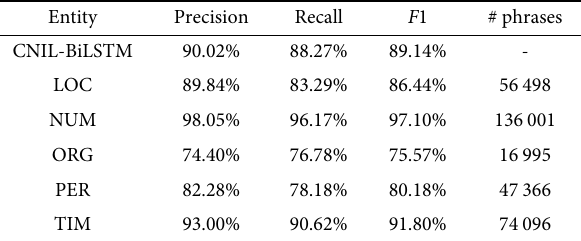
Table 2 Experimental results for each entity type.